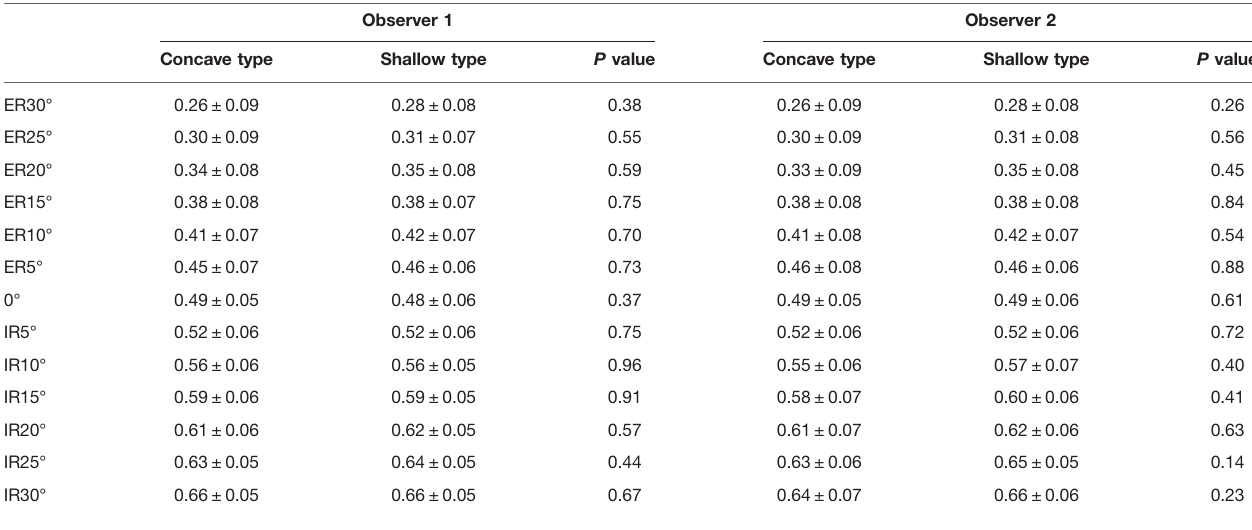
TABLE 2 | Effect of different gender on ratio α